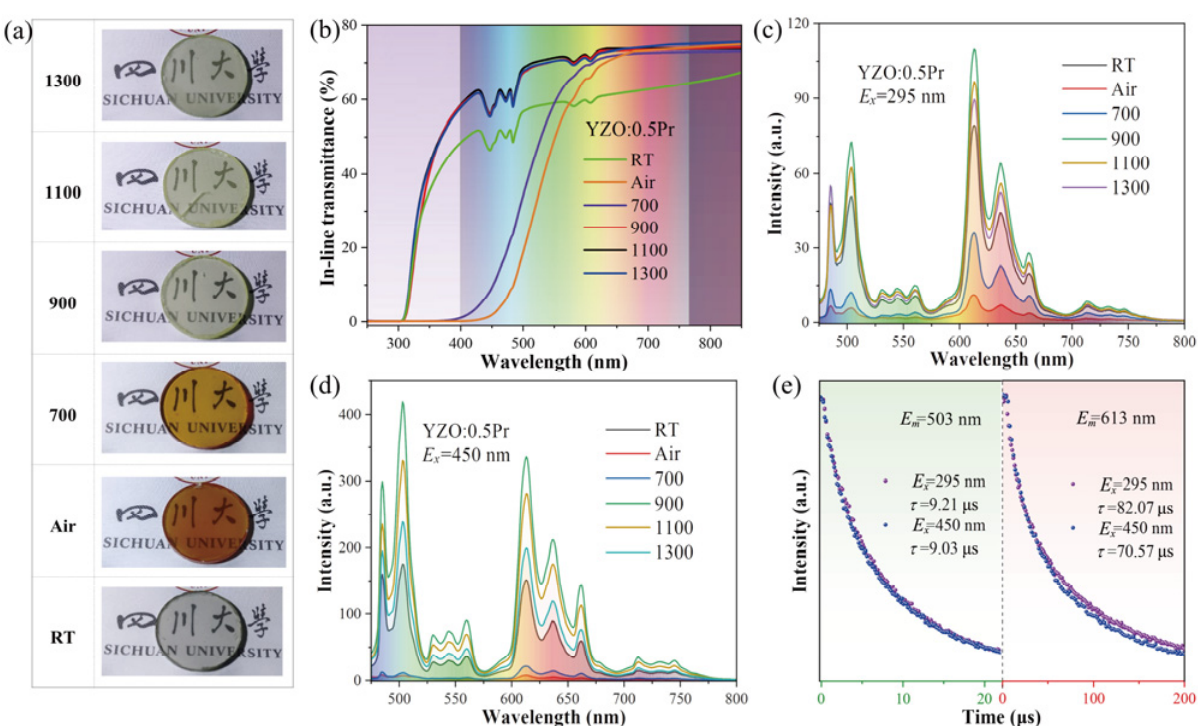
Fig. 4 (a) Photographic images and (b) in-line transmittance of YZO:0.5Pr ceramics treated at various temperatures. (c, d) Emission spectra under the excitation of 295 and 450 nm, respectively. (e) Typical florescence decay profile of YZO:0.5Pr ceramic detected at 503 and 613